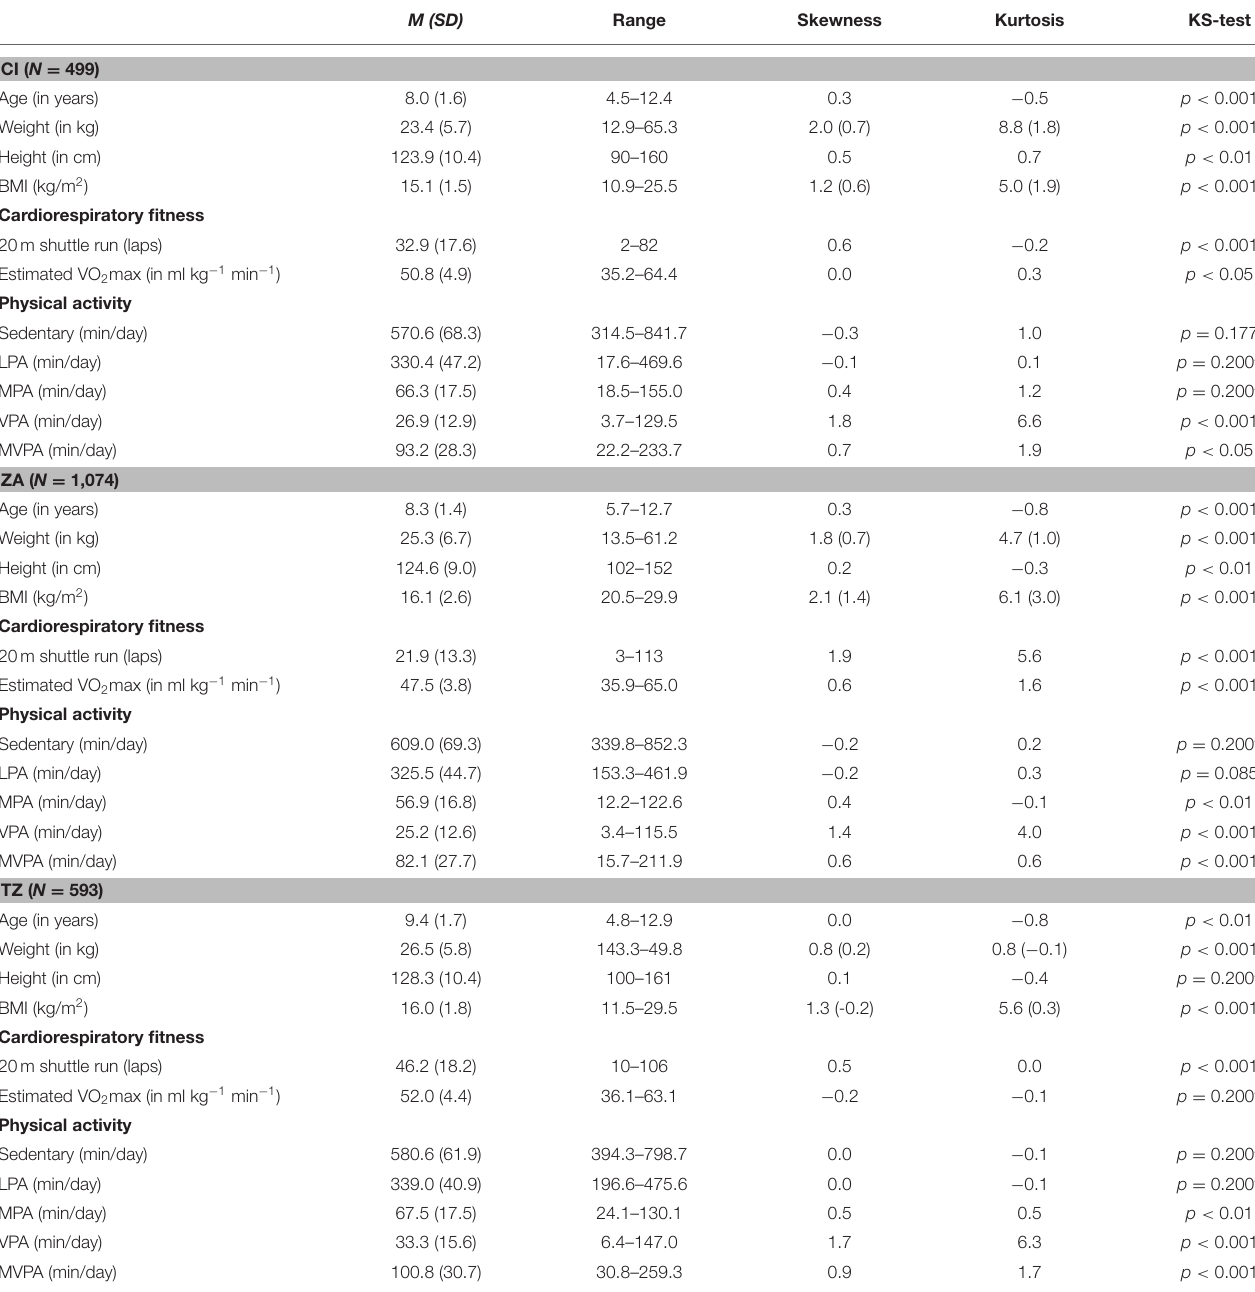
TABLE 2 | Descriptive statistics for the total sample, separately for children from Côte d’Ivoire (CI), South Africa (ZA), and Tanzania